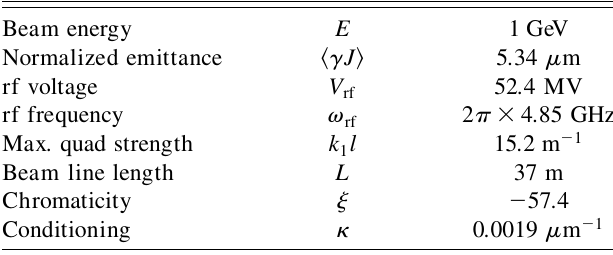
TABLE II. Parameters in the example matched chromatic conditioning beam line.